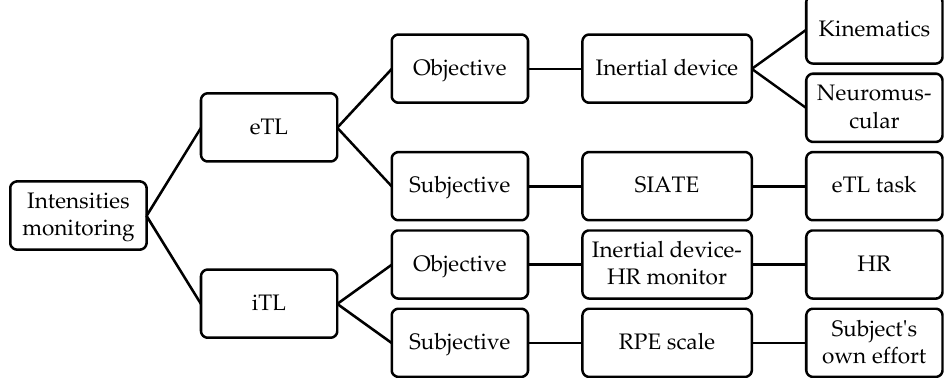
Figure 1. Classification of the intensities and measuring instruments according to García-Ceberino et al. [1]. Note: eTL = External Intensity; SIATE = Integral Analysis System of Training Tasks; iTL = Internal Intensity; HR = Heart Rate; RPE = Rating of Perceived Exertion.